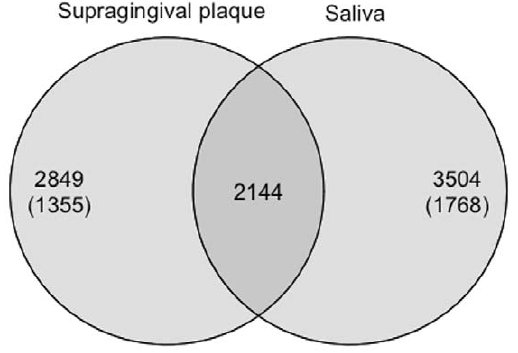
Figure 3. Venn diagram of the overlap between supragingival plaque observed operational taxonomic units (OTUs) vs. saliva observed OTUs. The numbers of singleton OTUs, detected from only one read from one subject, are shown in